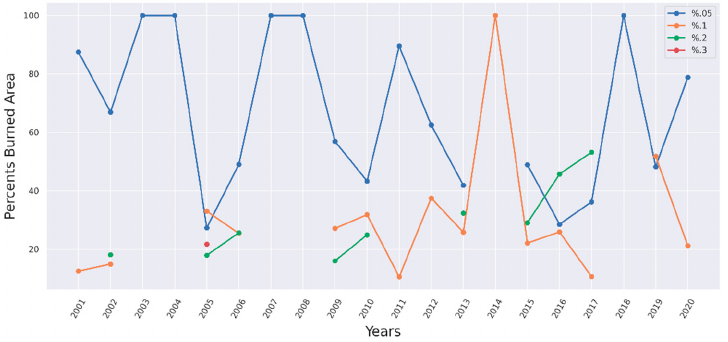
Figure 10. Total percent burnt area per year and per class. The blue line represents the annual total for the 100-500 ha class; in orange is the 500-1000 ha class; in green is the 1000-10,000 ha class; the greater than 10,000 ha class is in red.